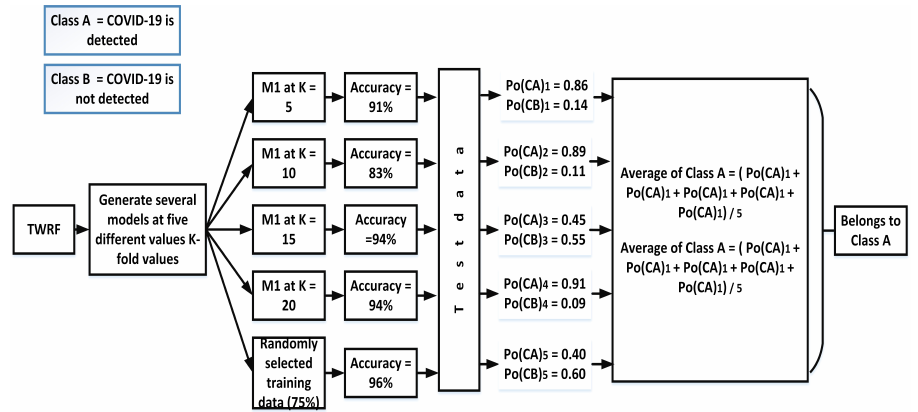
Figure 4. Assigning a particular class by incorporating soft voting.